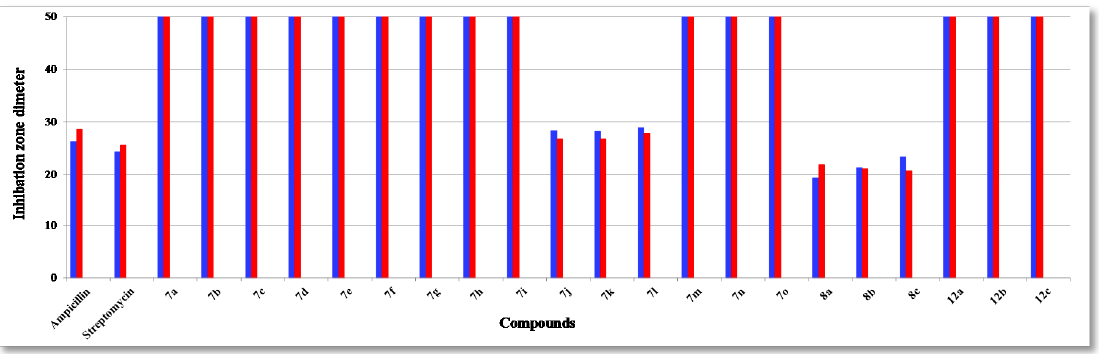
Figure 2. Antibacterial activity (Gram-negative) of tested compounds compared to ampicillin and streptomycin: P. aeruginosa (blue) and E. coli (red).